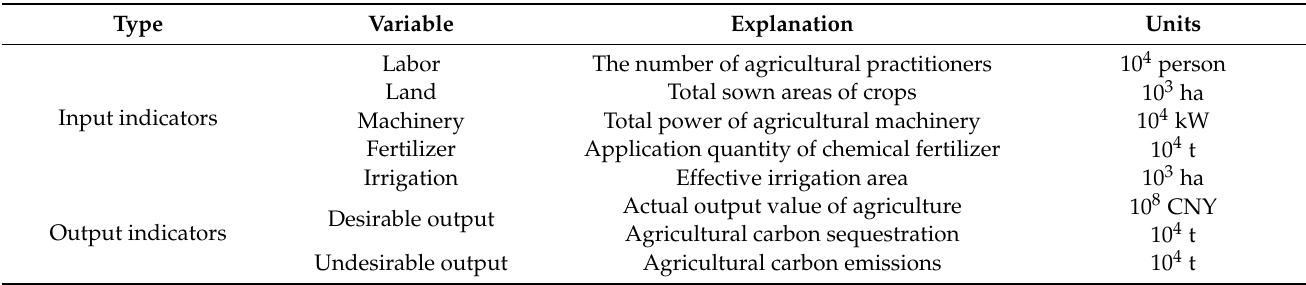
Figure 1. Study areas. Table 2. Input and output variables for the measure of